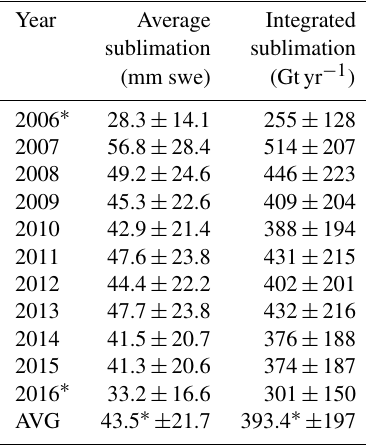
Table 1. The year average sublimation per year (average of all grid boxes) and the integrated sublimation over the Antarctic continent (north of 82 ◦